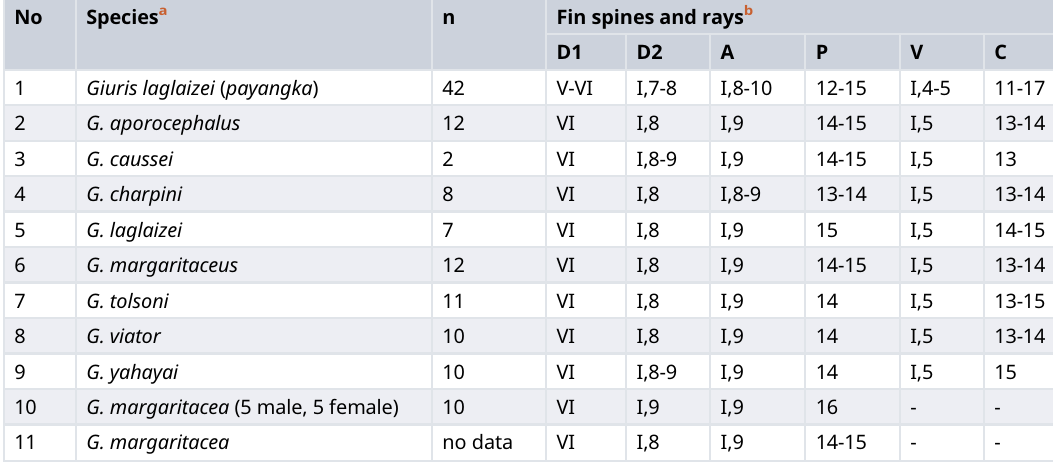
Table 9. Comparison of meristic characters within the genus